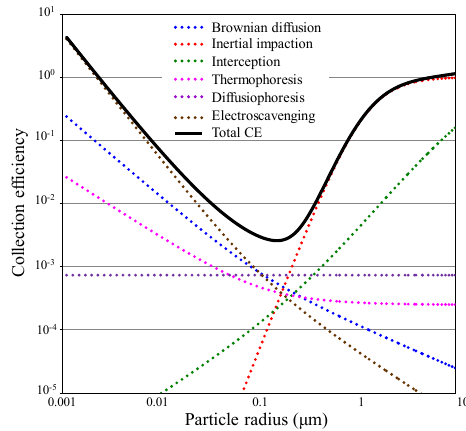
Figure 8. CE values for 50% RH and 400 elementary charges per droplets with different particles elementary charge for a droplet ra- dius of 21.6µm and room temperature.